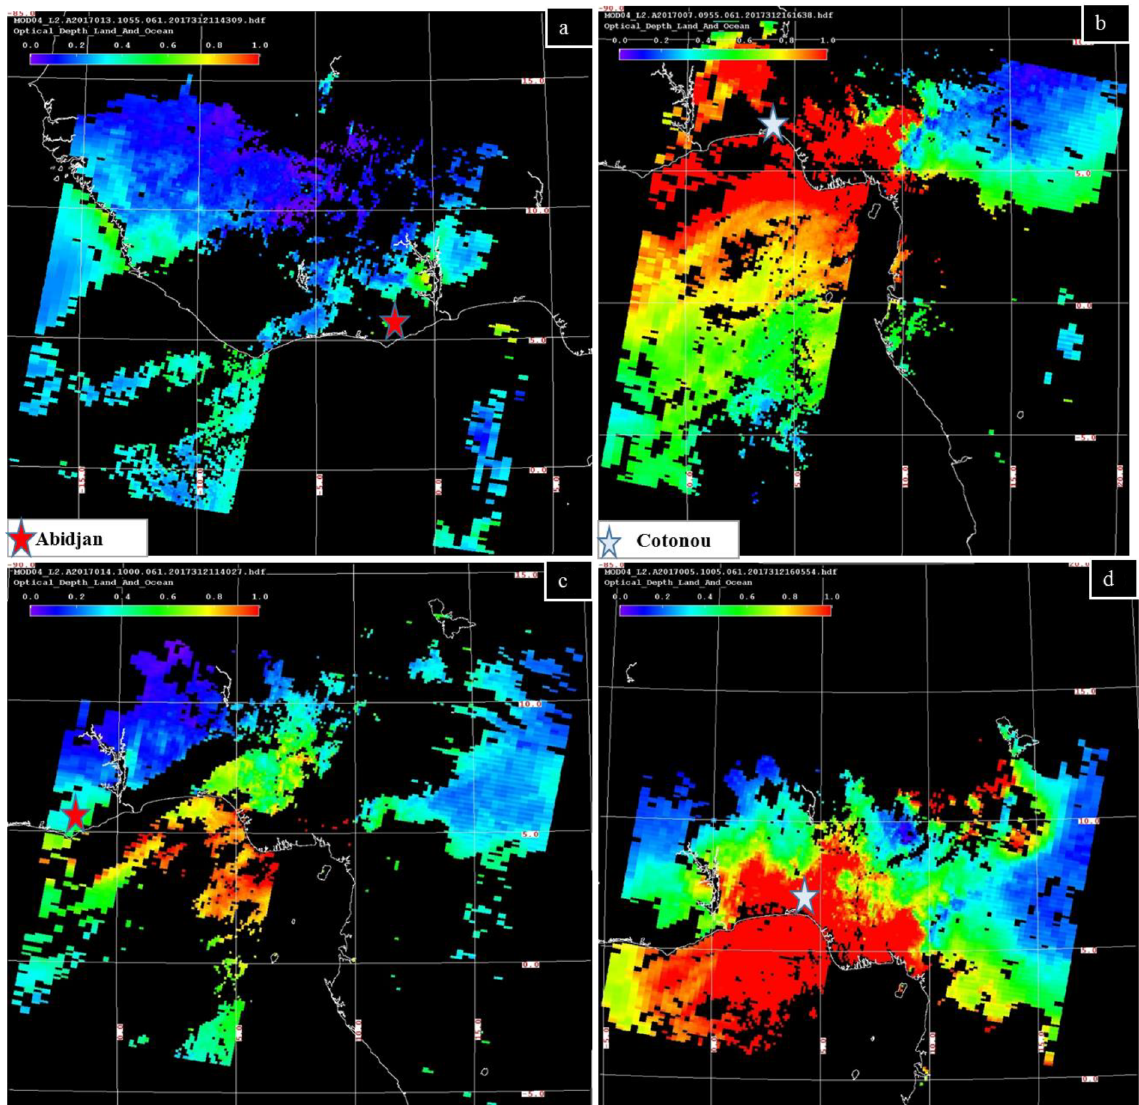
Figure 14. MODIS Aerosol optical depth regional distribution over West Africa. Data are for 2017, focusing on our campaign date at Abidjan ( a–c 11–12 January, left part) and Cotonou ( b–d 6–7 January, right